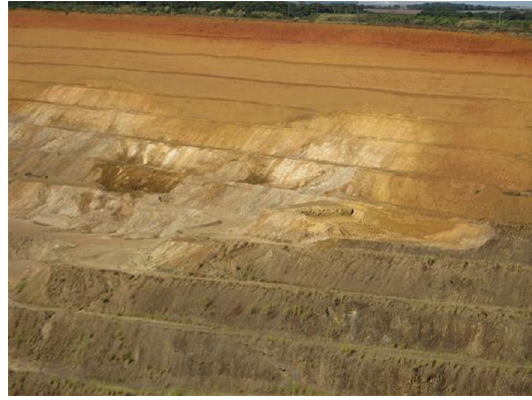
Figure 1. Front view of the TMC phosphate mine.